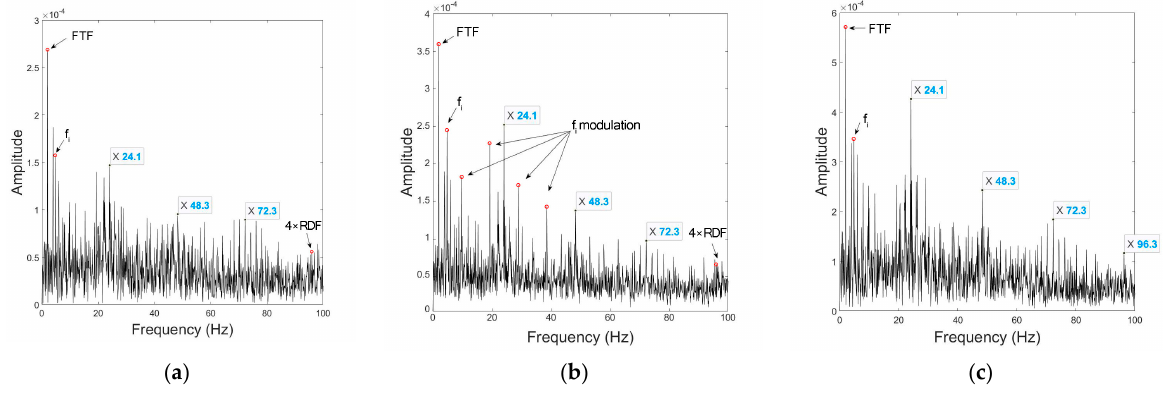
Figure 10. Envelopes under rolling element fault condition at 290 rpm of: ( a ) non − processed mono signal; ( b ) UCMA − ESPRIT beamformed signal; ( c ) CPCMA − ESPRIT beamformed